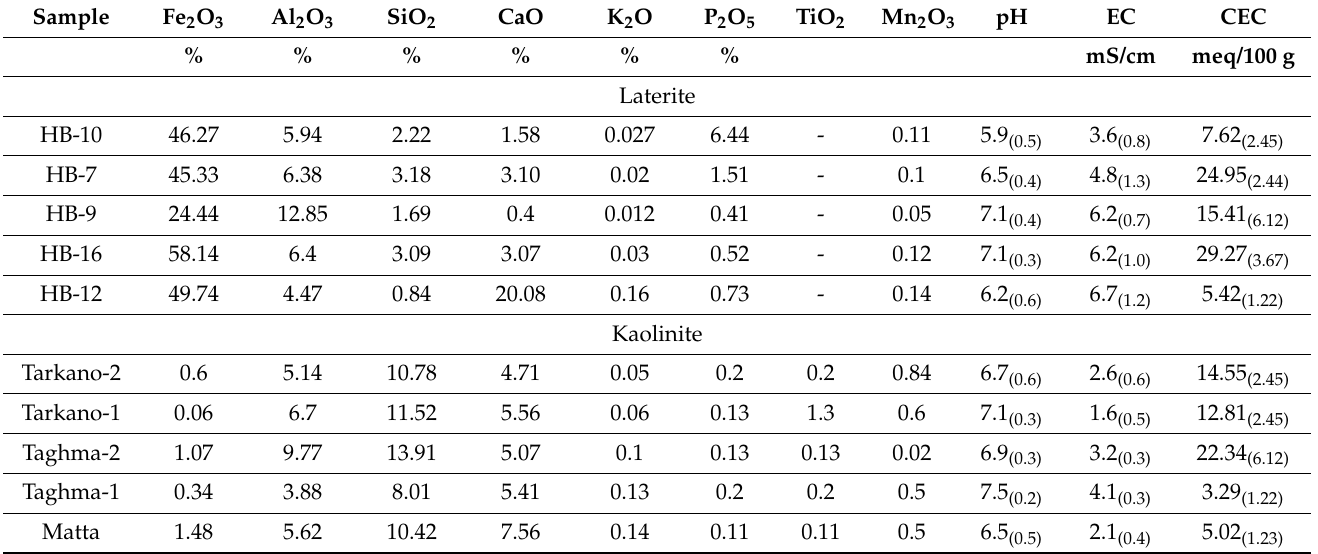
Table 1. Characteristics of the raw laterite and kaolinite